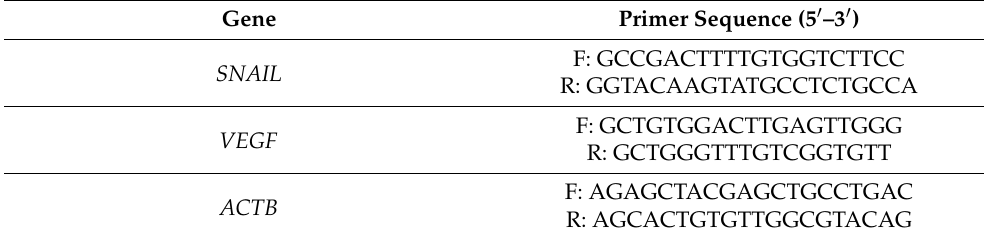
Table 4. Primer sequence of the gene detected in the qPCR assay.